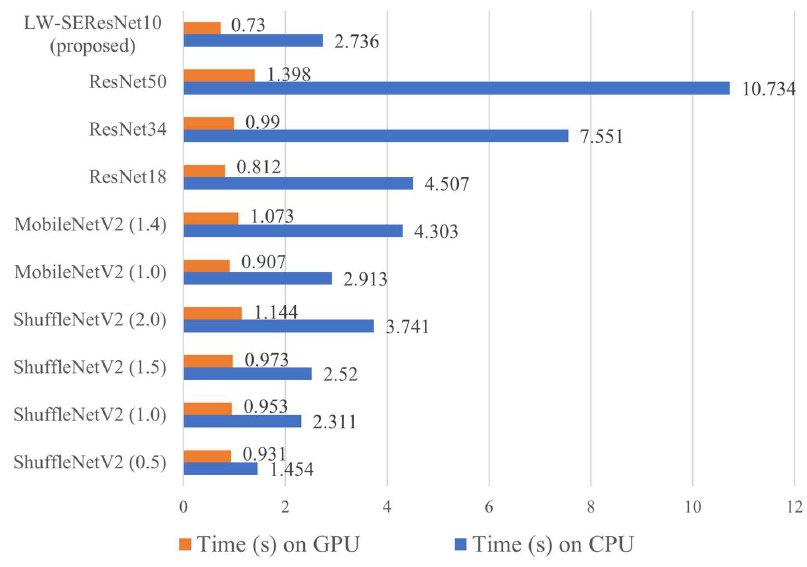
Figure 9. The inferred time of multiple models under the 3D dynamic MFCC feature.